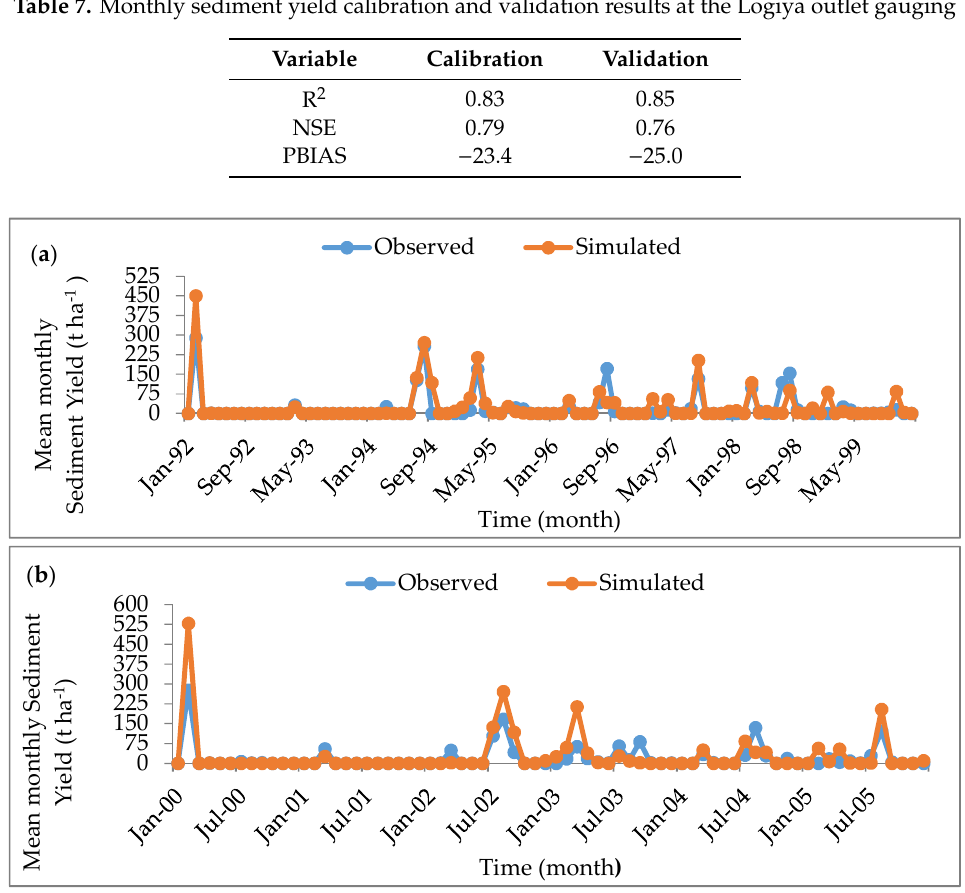
Figure 8. SWAT model calibration ( a ) and validation ( b ) for sediment yield at the monthly time scale during 1992–1999 and 2000–2005 respectively.